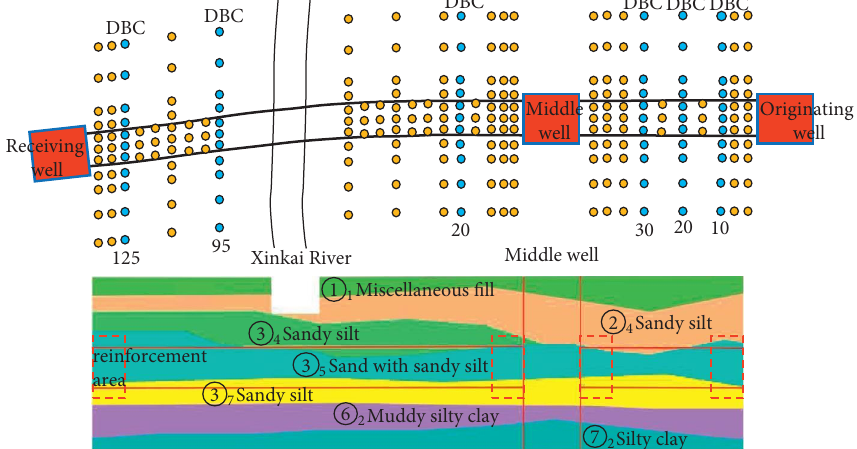
Figure 3: Stratum profile and field measurement section.